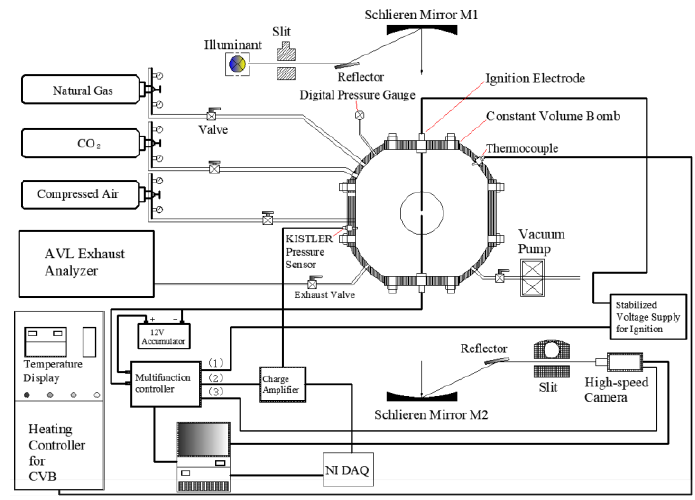
Figure 1. The experimental setup, consisting of a constant volume chamber, a Schlieren system, a temperature controlling and monitoring system, an intake and exhaust system, an AVL exhaust analyzer and a computer as a controller.